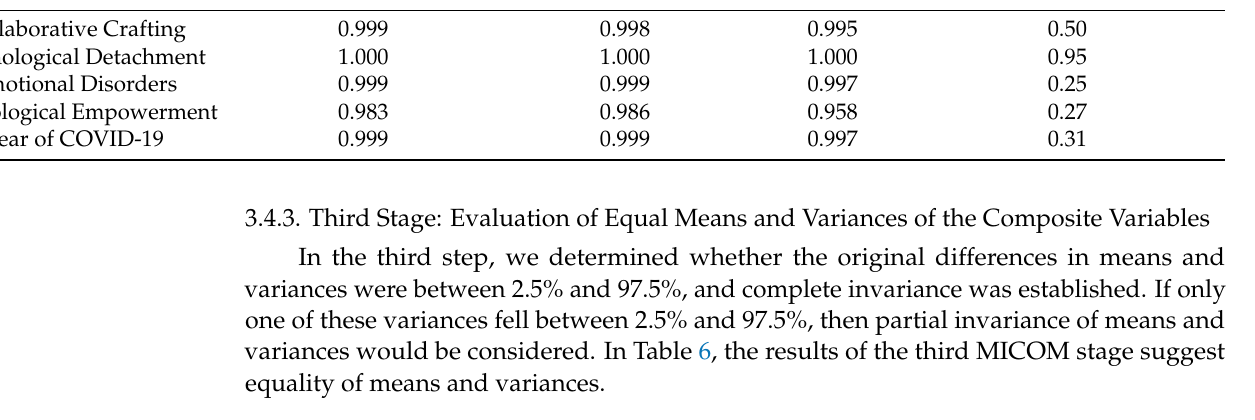
Table 6. MICOM. Stage 3 results. Original differences in mean and variance.